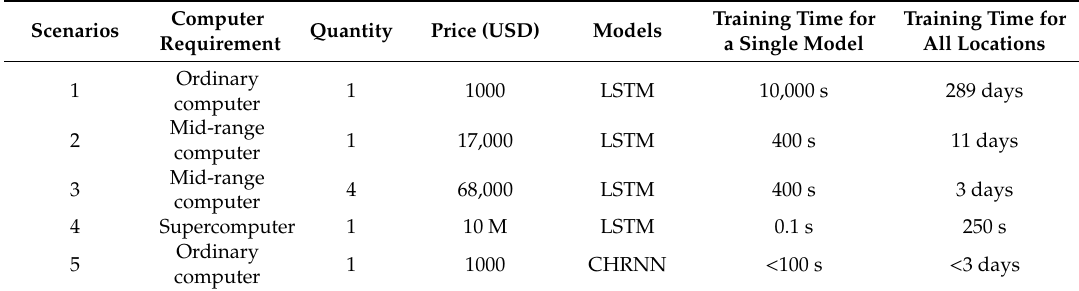
Table 1. Monetary costs (in 2020 prices) and time costs of di ff erent scenarios, in which scenarios 1 to 4 use long short-term memory (LSTM) while scenario 5 uses the combinational Hammerstein recurrent neural network